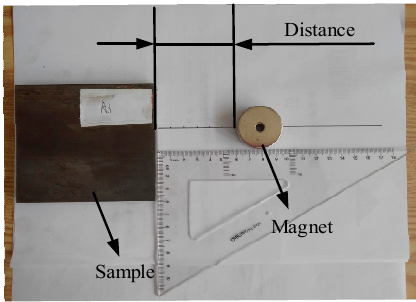
Figure 15. Sample and magnet.